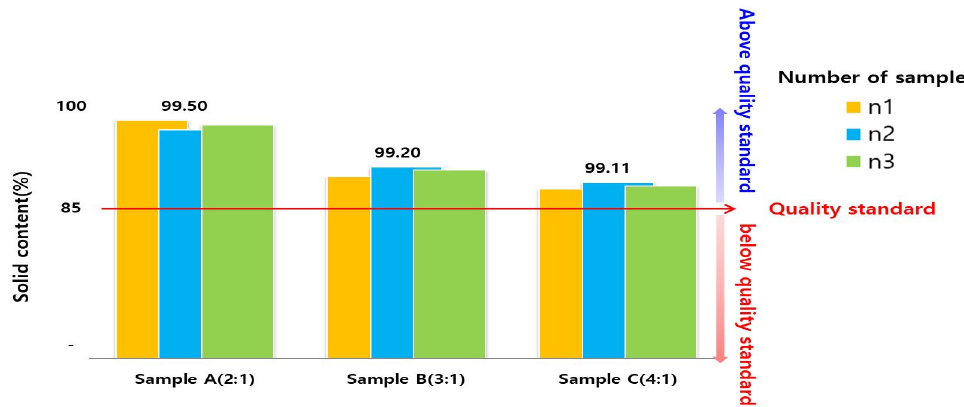
Figure 9. Solid content by sample of W-SPRG.